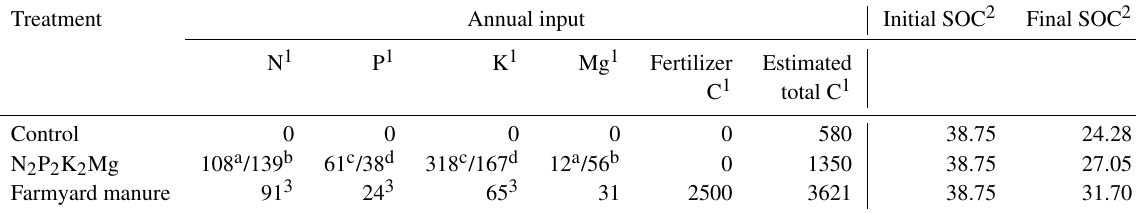
Table 1. The treatments considered in this study.